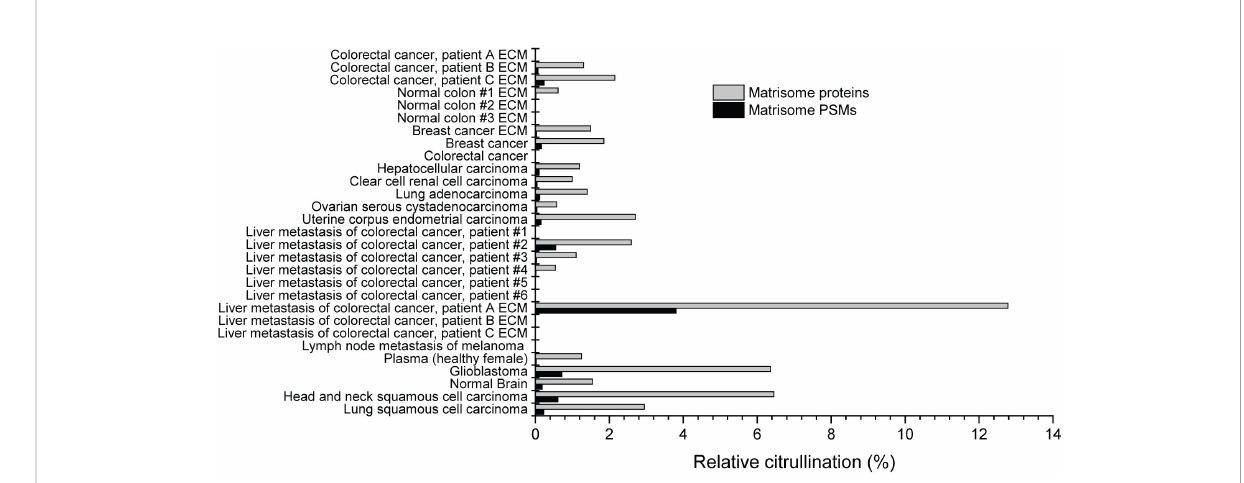
FIGURE 2 Citrullination of matrisome in various cancer and normal tissue samples. Raw data was obtained from public repositories (Table 1) and searched against Human Uniprot sequences including isoforms. The results were fi ltered to include only the citrullinated spectra matching to matrisome proteins. Only those citrullinated matrisome PSMs were accepted that passed the criteria presented in Figure 1. Relative citrullination was calculated by dividing the number of citrullinated matrisome PSMs/proteins with all detected matrisome PSMs/proteins in the sample. Matrisome protein was de fi ned as citrullinated if it had at least one citrullinated PSM. As indicated, some datasets are from samples speci fi cally enriched for ECM